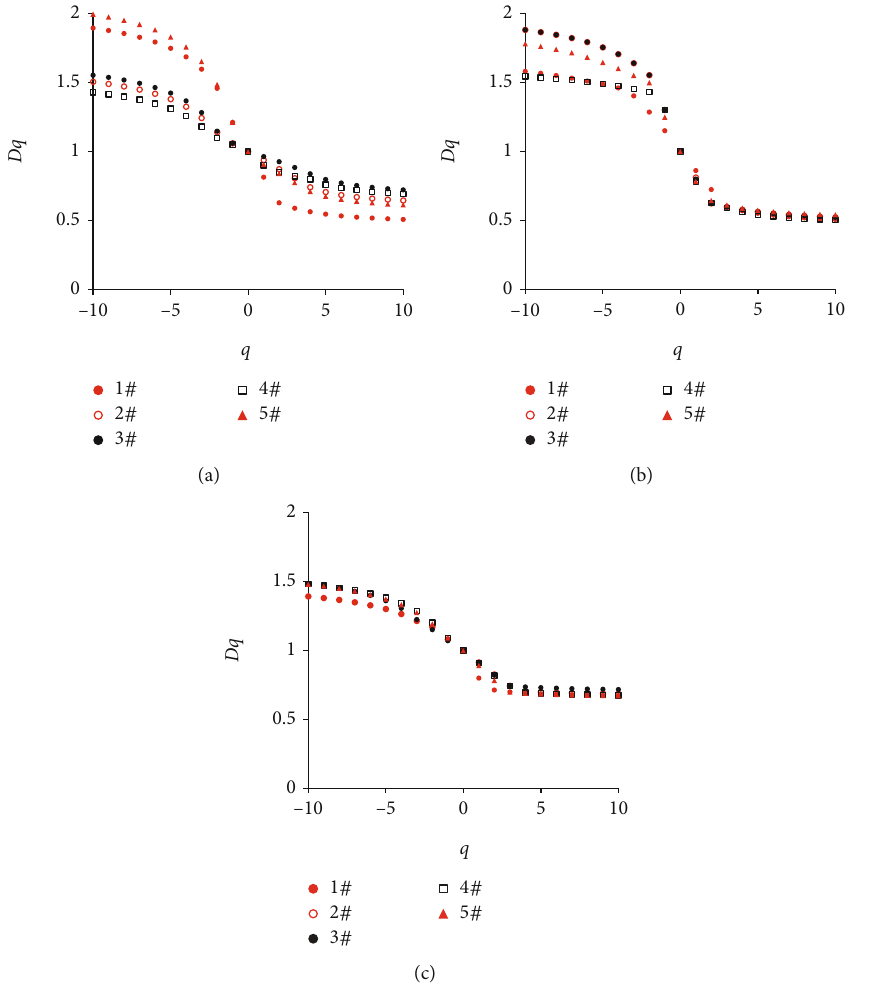
Figure 8: Generalized dimension D q spectra of C7 shale derived from (a) LTA method, (b) PCMI method, and (c) NMR test.